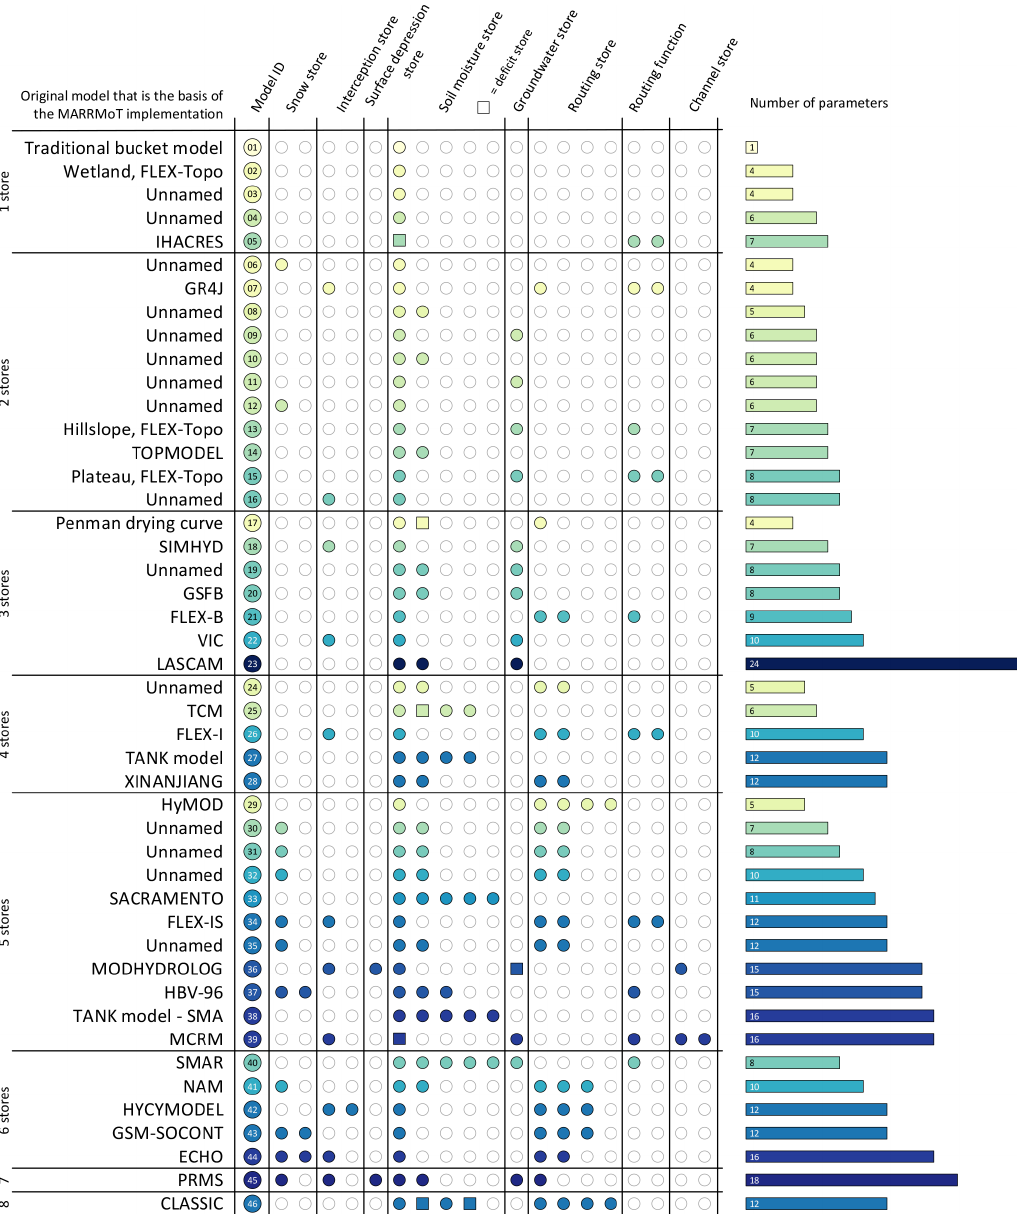
Figure 2. Overview of MARRMoT models. Models are sorted vertically by number of stores (one at the top, eight at the bottom). The columns show broad categories of hydrologic process that can be represented by a model. Coloured circles indicate the model has a store dedicated to the representation of this hydrological process (squares indicate a deficit store). The bar plot on the right shows each model’s number of parameters. Colouring refers to the number of